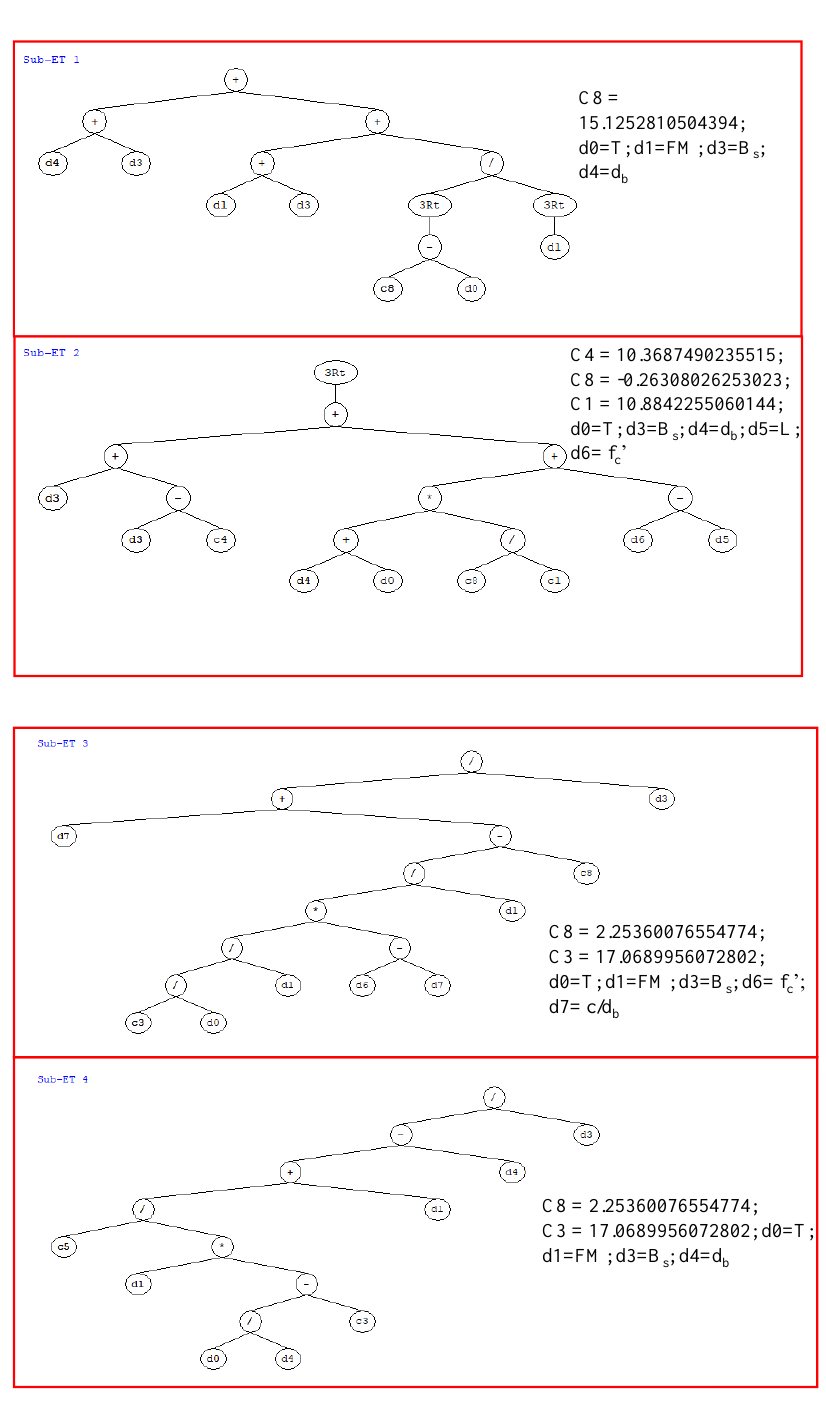
Figure 8. Expression tree obtained from optimised trial in GEP modelling.